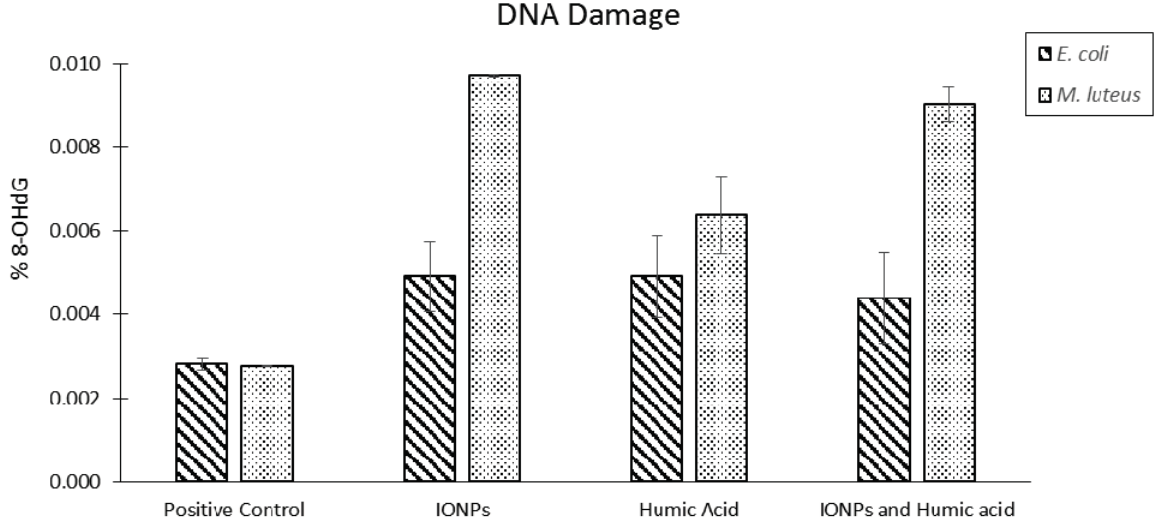
Figure 8 . Percentage of DNA damage (as assessed by 8-OHdG levels) for each condition at the 24 h time